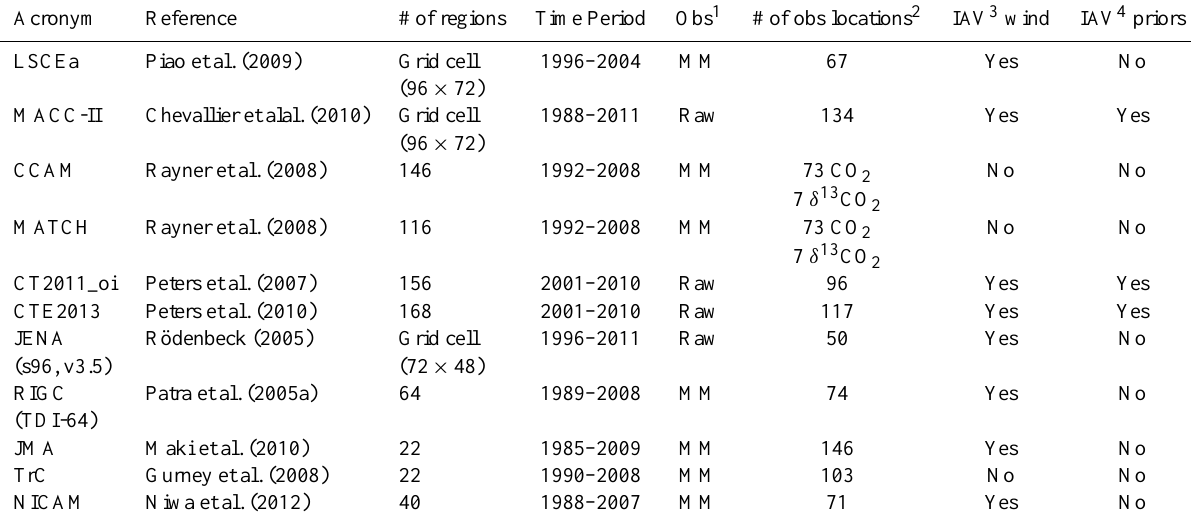
Table 1. Participating inversion systems and key